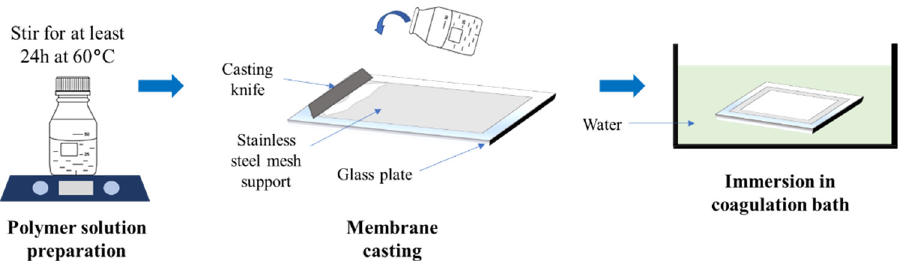
Figure 1. An illustration of phase inversion method for membrane fabrication applied in the present study.